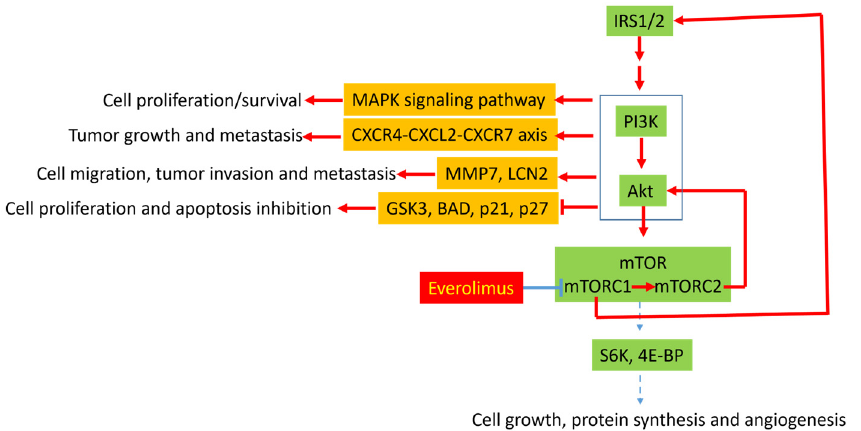
Figure 1. Potential mechanisms underlying everolimus resistance in gastroenteropancreatic neuroendocrine tumors. Inhibition of mTORC1 by everolimus may leads to activation of mTORC2 and elevate insulin receptor substance 1 and 2 (IRS1/2) via disrupting mTORC1-mediated negative feedback. IRS1/2 leads to activation of PI3K/Akt signaling pathway. In addition, mTORC2 also activates Akt by phosphorylation. Activation of PI3K/Akt leads to cell proliferation, tumor growth, apoptosis inhibition, tumor cell migration, tumor invasion, and metastasis through (1) activation of MAPK signaling pathways, (2) activation of CXCR4-CXCL2-CXCR7 axis, (3) overexpression of MMP7 and LCN2, and (4) inhibition of GSK3, BAD, p21, and p27.